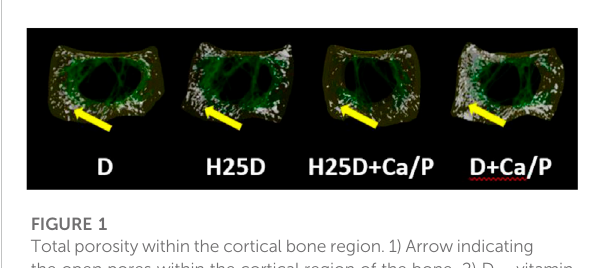
FIGURE 1 Total porositywithin the cortical boneregion.1) Arrow indicating the open pores within the cortical region of the bone. 2) D = vitamin D3(2,760 IU/kg);H25D=vitaminD3(2,760 IU/kg)+62.5 mgHyD/ton (full dose); H25D + Ca/P = vitamin D3 (2,760 IU/kg) + 62.5 mg HyD/ton(fulldose)+10% – 30%higherCa&Plevels;D+Ca/P=vitamin